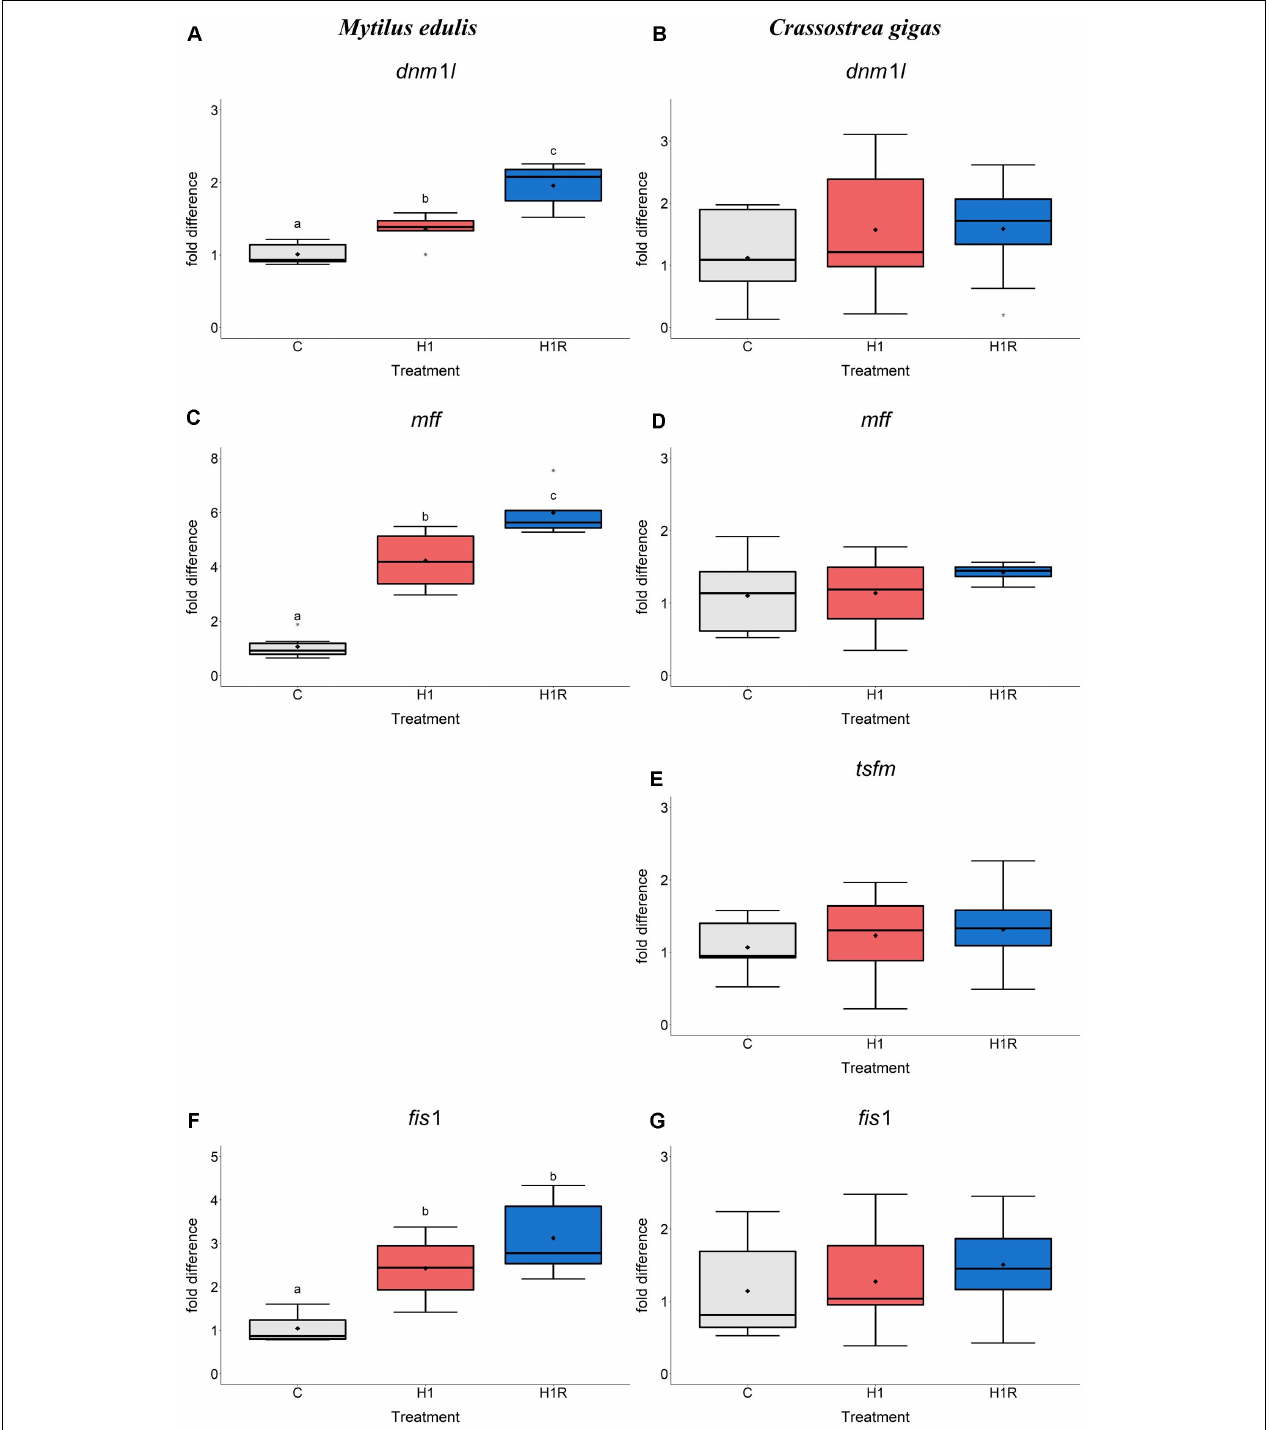
FIGURE 2 | mRNA expression of mitochondrial fission proteins in M. edulis and C. gigas hepatopancreas in response to H/R stress. (A,C,F) M. edulis ; (B,D,E,G) C. gigas ; (A,B) dnm 1 l mRNA; (C,D) mff mRNA; (E) tsfm mRNA; (F,G) fis 1 mRNA. Experimental groups: C, control; H1, short-term (1 day) severe hypoxia; H1R, short-term (1 day) severe hypoxia and subsequent 1.5 h reoxygenation. Means are depicted as points within corresponding Box-Whisker-plot. Outliers are shown as asterisk (*). Different letters above plots represent values that are statistical significantly different from each other ( p < 0.05). Plots sharing a letter are not significantly different ( p > 0.05). N =